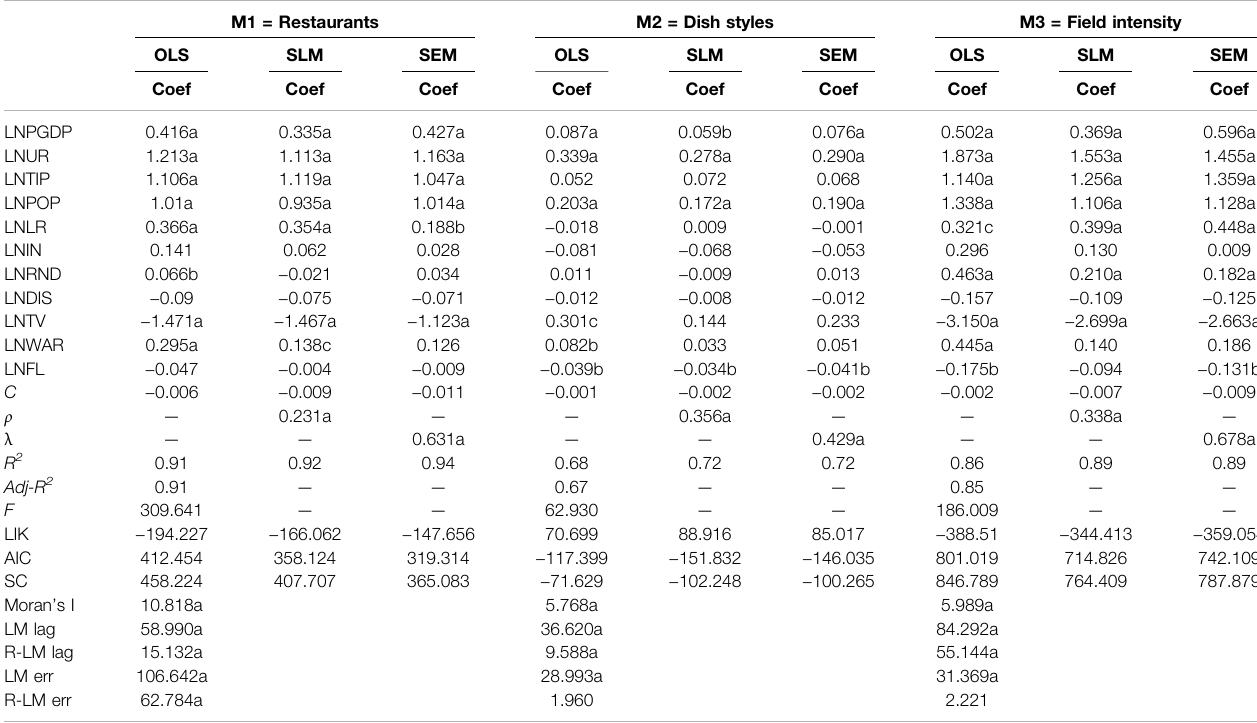
TABLE 3 | Results of models 1, 2, and 3 M1 =